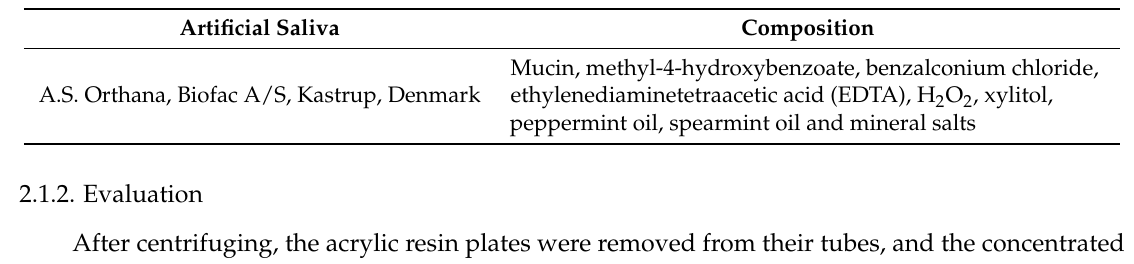
Table 2. Composition of artificial